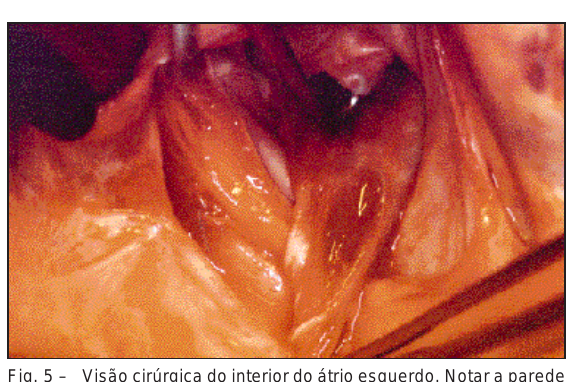
Fig. 5 – Visão cirúrgica do interior do átrio esquerdo. Notar a parede posterior do átrio esquerdo tracionada para fora da cavidade atrial esquerda (aneurisma da parede posterior do átrio esquerdo).